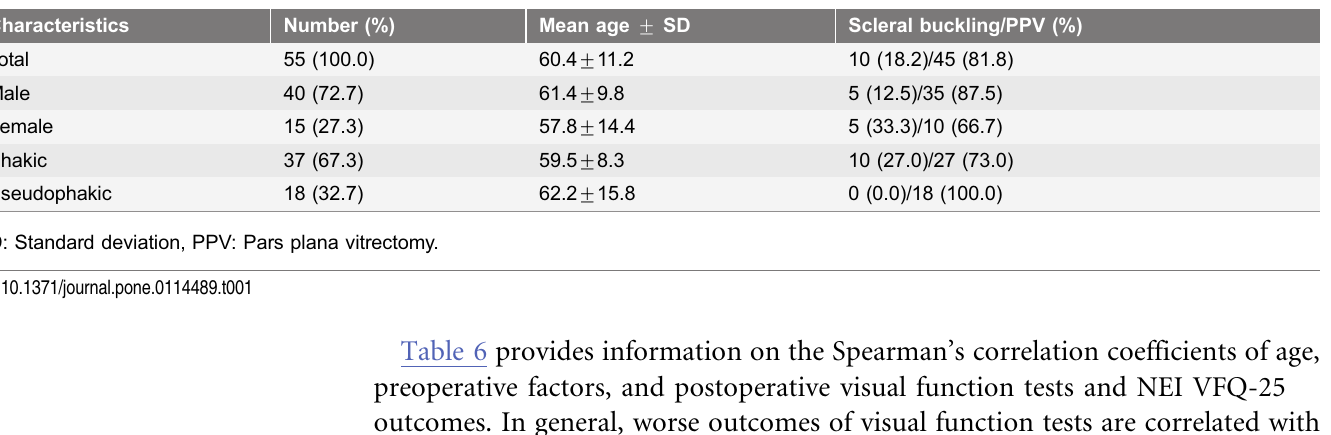
and NEI VFQ-25 scores.